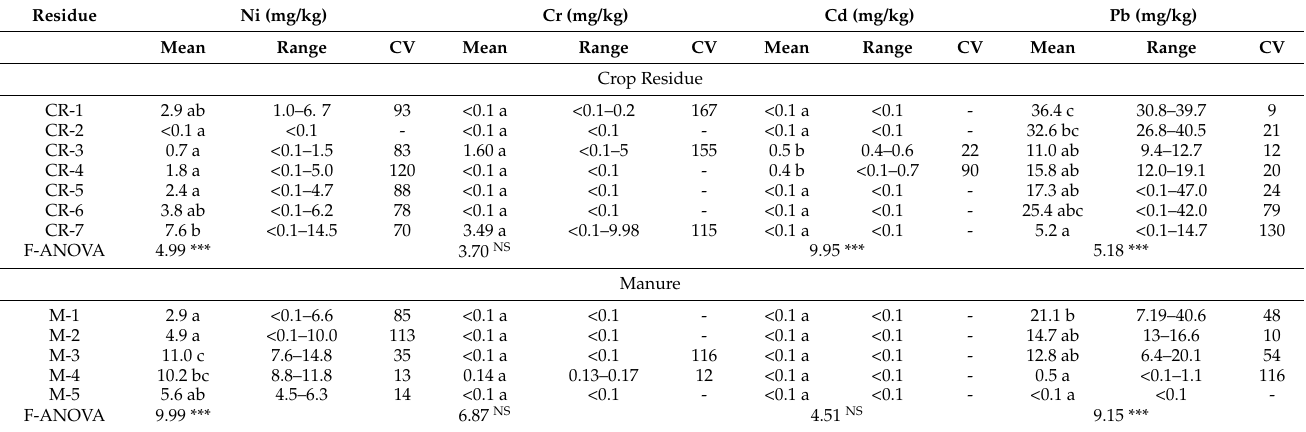
Table 5. Heavy metal contents (on a dry weight basis) of the agro-livestock